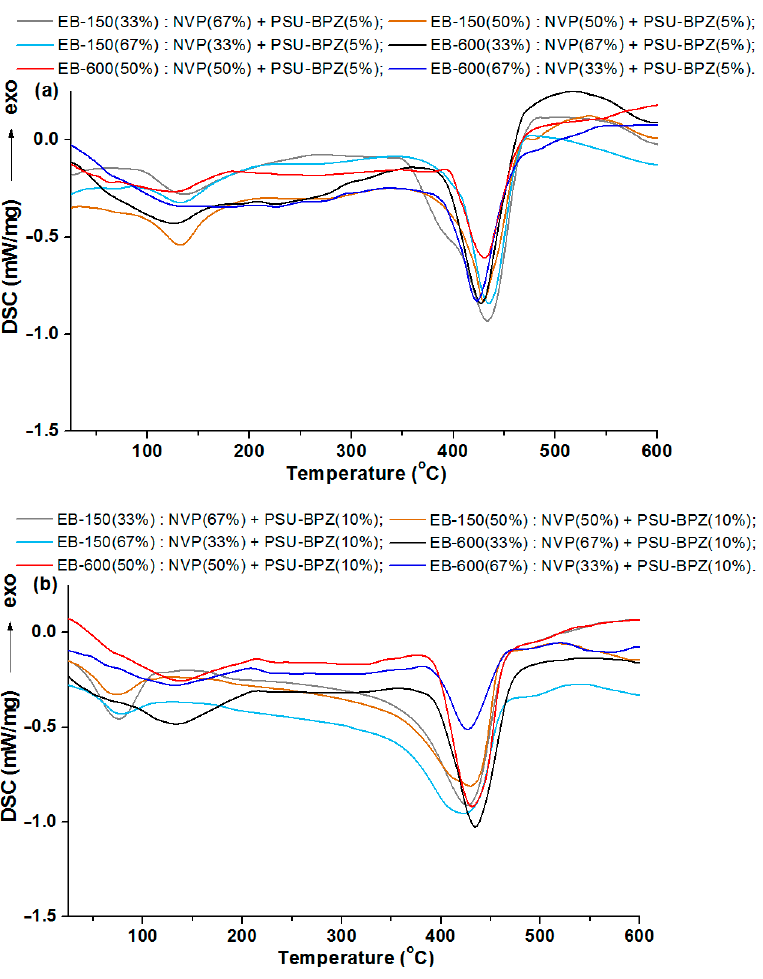
Figure 12. DSC curves of the blends: ( a ) samples with 5 wt.% of PSU-BPZ; ( b ) samples with 10 wt.% of PSU-BPZ.